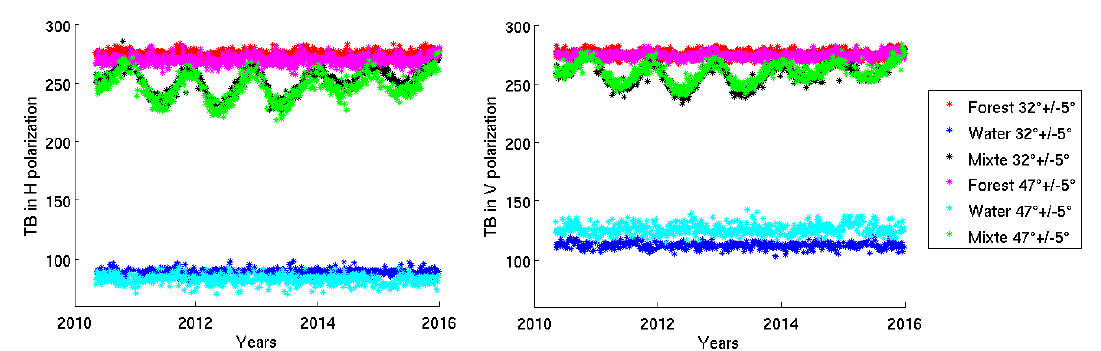
Figure 4. Time series of TB at H polarization (left) and V polarization (right) at two incidence angles (32 ◦ ± 5 ◦ and 47 ◦ ± 5 ◦ ): the “water”, “forest” and “mixed”